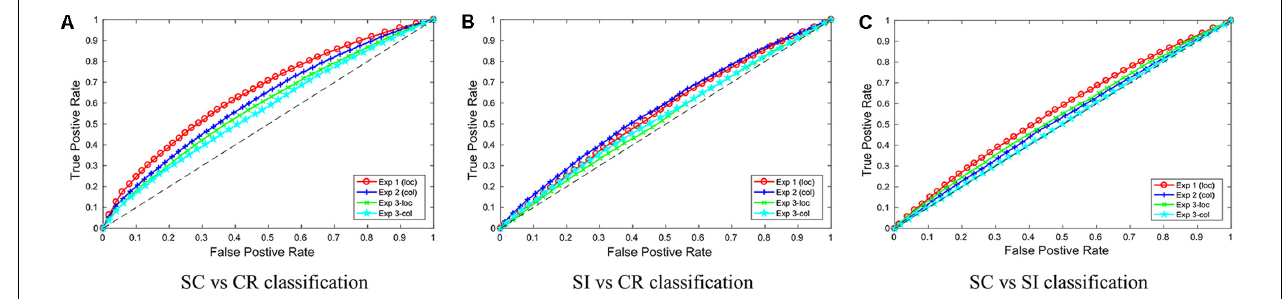
FIGURE 4 | The ROC curves for the three different classification problems ( A : SC vs. CR; B : SI vs. CR; and C : SC vs. SI) are given separately for the four individual datasets.